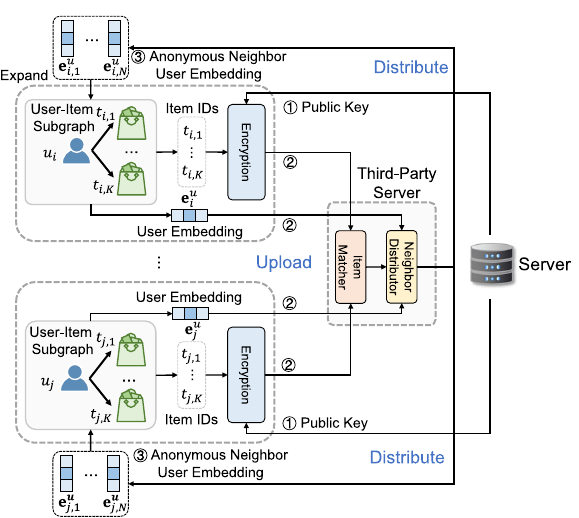
Fig. 8 The framework of the privacy-preserving user-item graph expansion protocol. The server fi rst generates and sends a public key to clients for encrypting local item IDs, and the clients upload the ciphertexts to a third-party server for matching the same items. The users with co- interacted items are regarded as neighbors, and the anonymous neighbor user embeddings with their corresponding connected encrypted items are distributed to the clients for expanding local